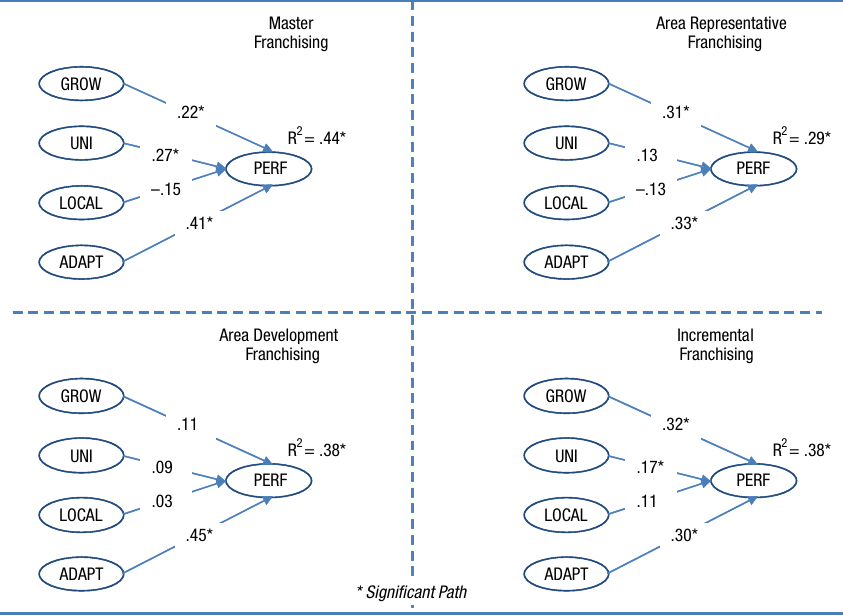
Fig. 2. Comparative results across structural